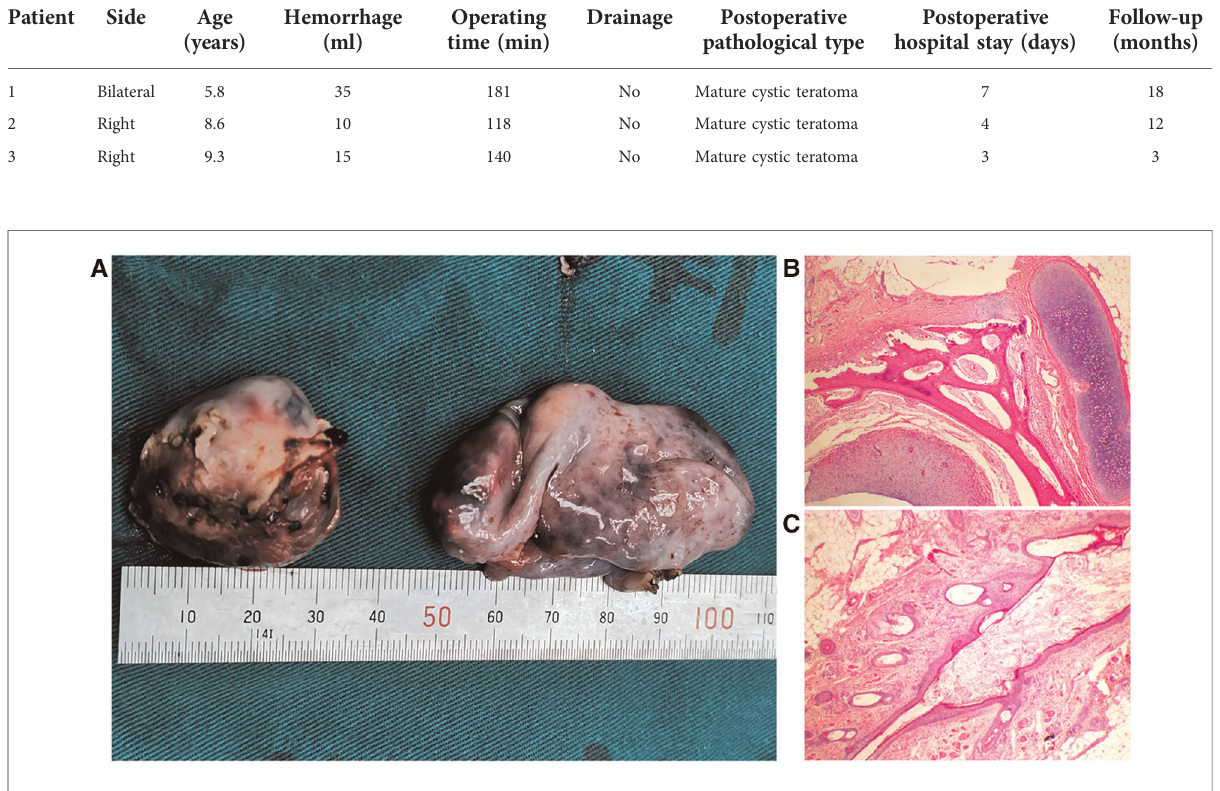
FIGURE 4 Typical photograph and pathological examination of ovarian tumors: ( A ) typical photograph of ovarian tumors and ( B,C ) pathological examination of ovarian tumors. The images indicated mature cystic teratomas.